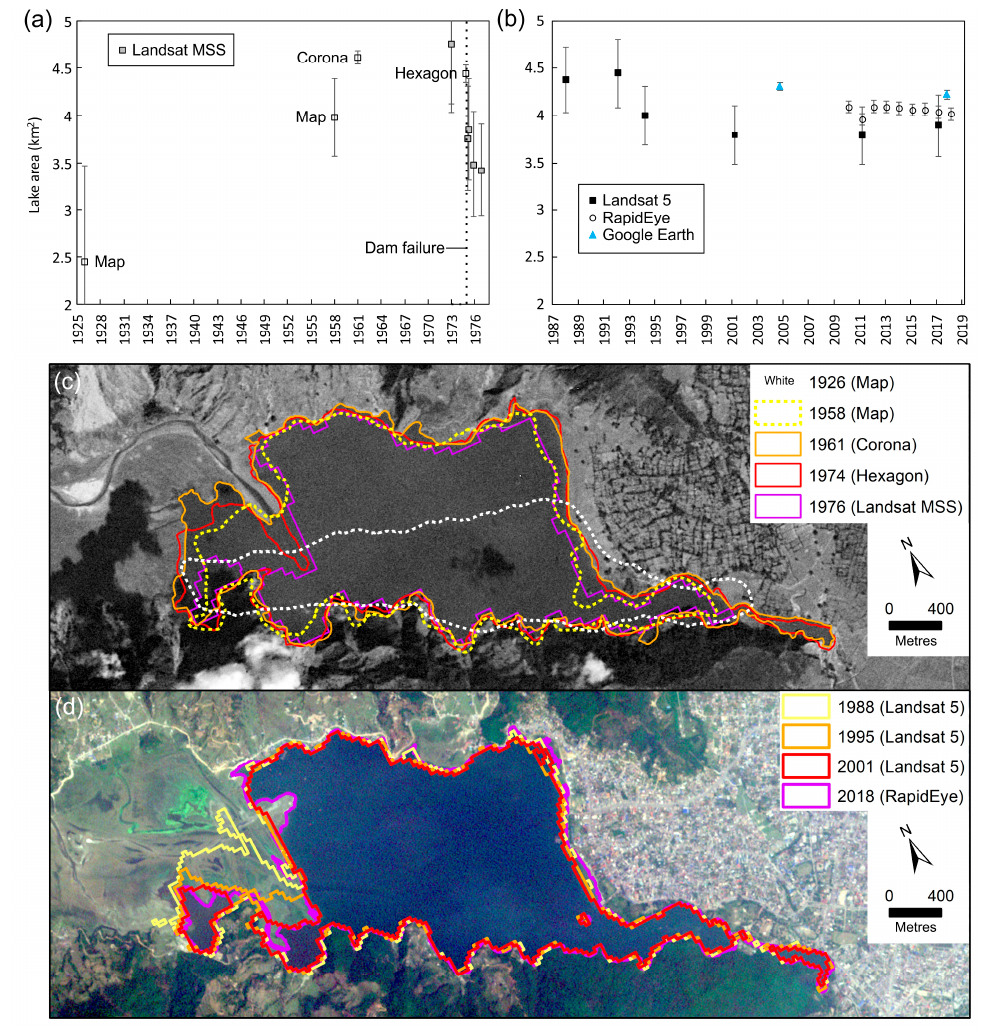
Figure 2. Changes in lake area before and after the most recent dam (1982). ( a ) Lake area change from 1926–1976 and ( b ) 1988–2018. ( c ) Lake shoreline change from 1926–1976 shown on a 1962 Corona satellite image, and ( d ) 1988–2018 shown on a RapidEye satellite image (April 2018). The 1926 and 1958 outlines are dashed due to georeferencing and geodetic uncertainty.